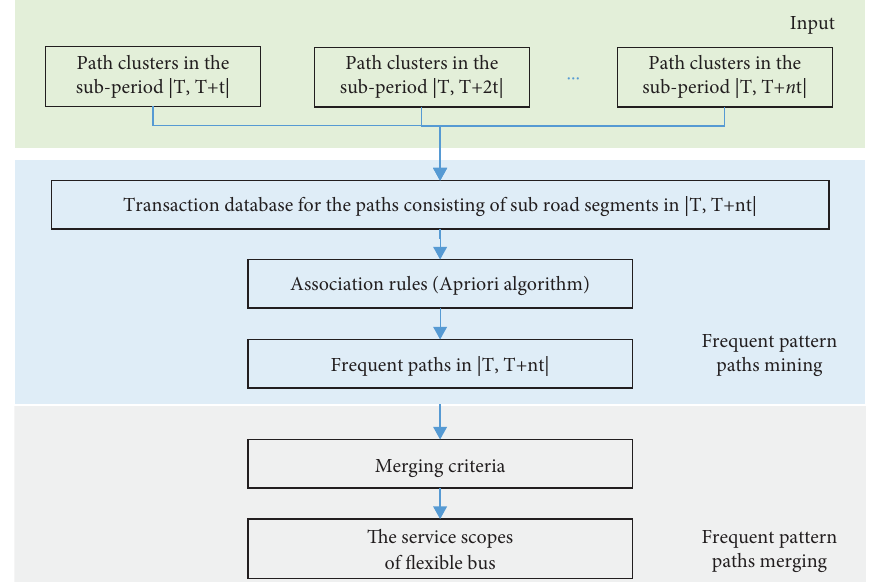
Figure 6: Process of frequent pattern paths mining and